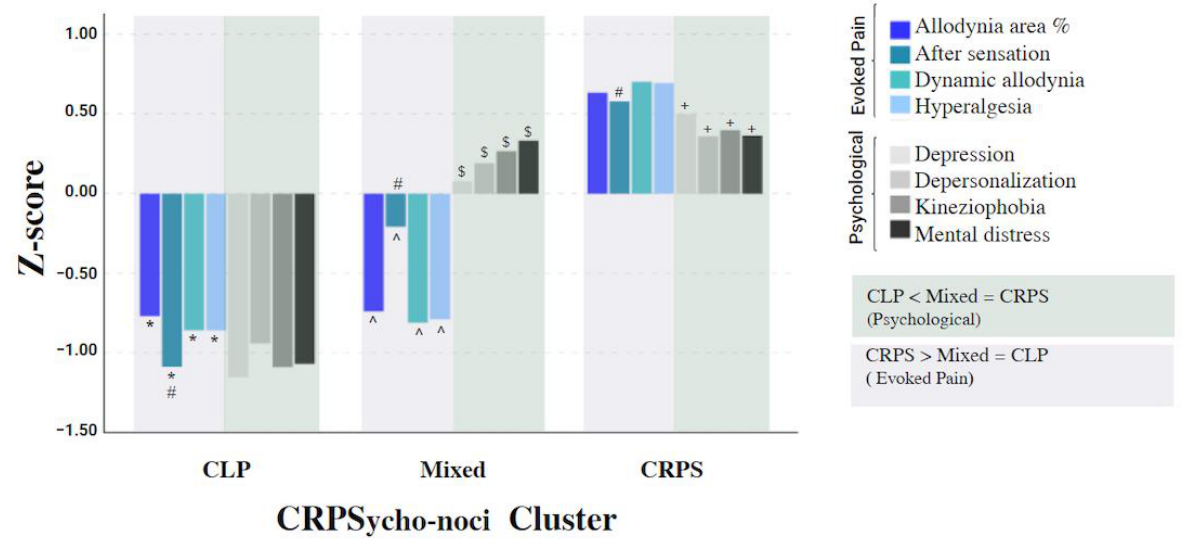
Figure 3. The three groups of the CRPSyco-noci cluster. Note. CRPS—Complex Regional Pain Syndrome; CLP—chronic limb pain; evoked pain and psychological measures distinguish between CLP, Mixed, and CRPS groups. All measures were z transformed. CLP showed lower values than CRPS in evoked pain measures (* CLP vs. CRPS) and CRPS showed higher values than CLP in psychological measures (+ CRPS vs. CLP). The Mixed group showed lower scores than CRPS in evoked pain measures (ˆ Mixed vs. CRPS) and higher scores than CLP in psychological measures ($ Mixed vs. CLP). After-sensation significantly differed in all groups (#).